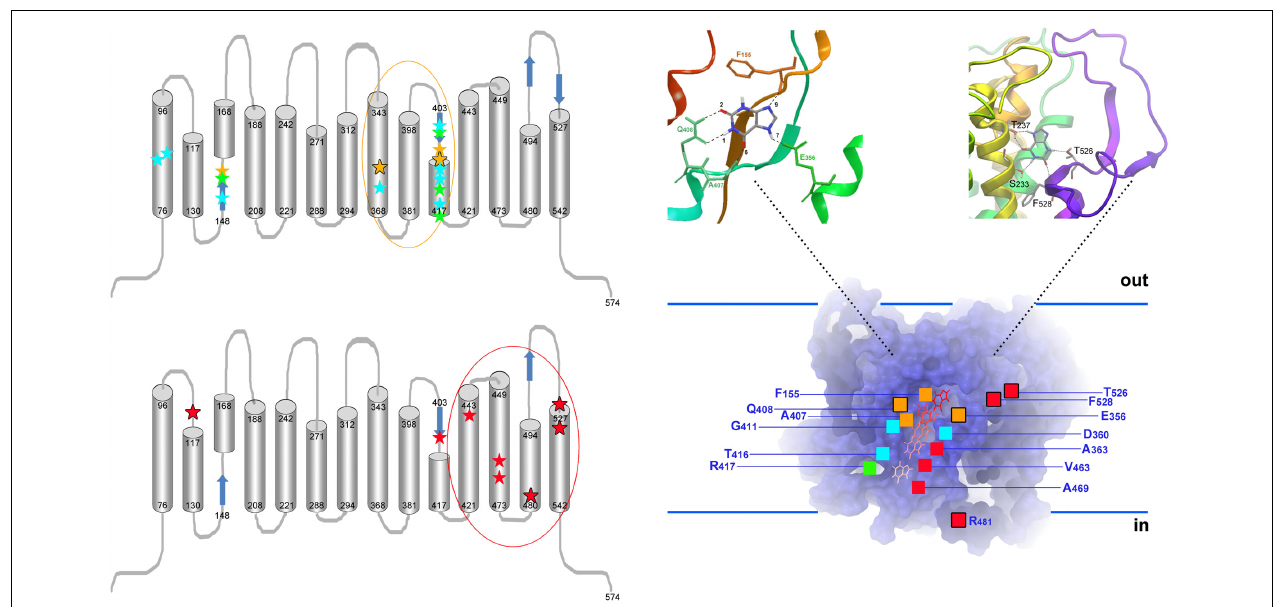
FIGURE 3 | Topology of UapA residues critical for function and specificity. Left, upper panel: Topology of residues critical for the function and transport kinetics of UapA. All important residues map in TMS1, TMS3, TMS8, and TMS10. Residues interacting directly with substrate (xanthine) are highlighted as yellow stars (Ser155, Glu356, A407, and Gln408). Among those, Glu356 and Gln408 interact with substrates through their side chains (further highlighted with a black outline). These two residues are irreplaceable for function. In green are residues (Ser154, Phe406, G411, Arg417) affecting the local topology of neighboring substrate-binding residues. Mutations in these residues can differentially affect the affinity for different substrates (e.g., uric acid vs. xanthine). In blue are residues (Gln85, His86, Met151, Asp360, Thr405, Asn409, Asn410, and Thr416) involved in dynamic interdomain interactions between helices TMS1, TMS3, and TMS10 (e.g., Gln86-Thr416, His86-Asn409, His86-Met151, Asp360-Asn410-Thr416). Mutations in these residues, which are often cryosensitive, abolish or dramatically reduce transport activity without affecting significantly substrate binding. Little is known on the residues binding H + ions, but a Glu356 and Asp360 are possible candidates. Evidence for the above conclusions comes from functional assays of a plethora of mutants using a set of > 25 different purines or purine related analogs,aswellas,dockingandMDapproaches.Amongmutationsconcerning residues critical for determining the affinity (K m / i values) for physiological substrates and ligands, only Gln408Glu shifts significantly the binding specificity of UapA toward novel ligands (hypoxanthine, guanine, uracil). Importantly however, even in this case, the mutated UapA cannot transport the novel ligands. In other, words no mutation affecting the functioning of the presumed substrate binding site modifies dramatically the specificity of UapA. Left, lower panel: Topology of residues critical for determining the substrate specificity of UapA. All important residues map in TMS11 (Ala441), TMS12 (Val463, Ala469), TMS13 (Arg481), TMS14 (T526, Phe528) and in the